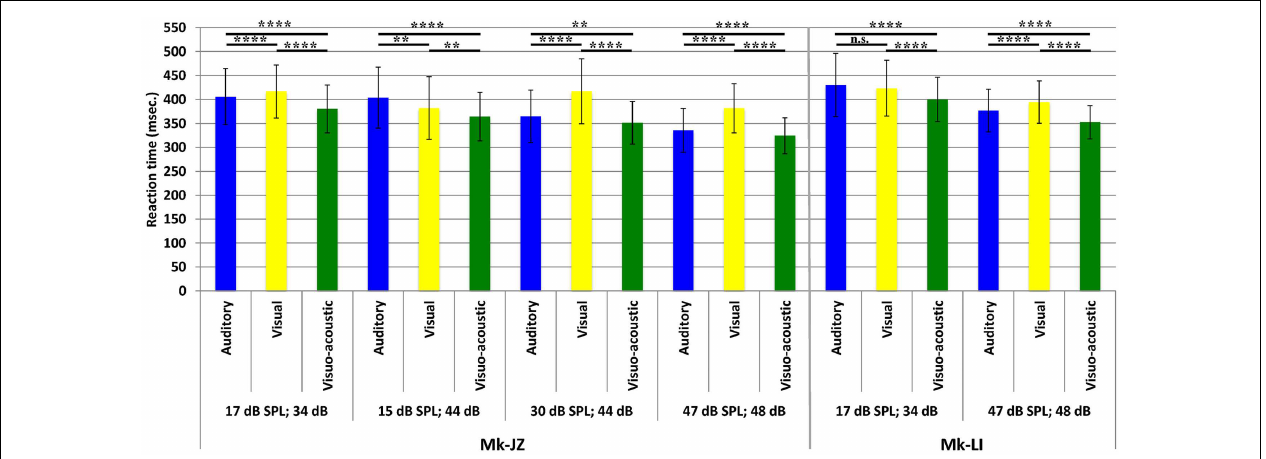
FIGURE 5 | Mean reaction times (with their SDs) obtained for different combinations of supra-threshold intensities and for both monkeys (Mk-JZ and Mk-LI) . n.s.: p ≥ 0.05; ** p < 0.01; **** p < 0.0001 (Mann–Whitney test).The data were derived from the electrophysiological daily sessions’ collection.